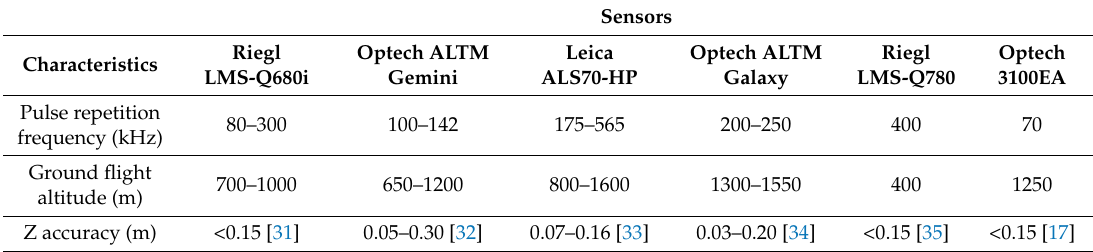
Table 2. LiDAR acquisition characteristics by